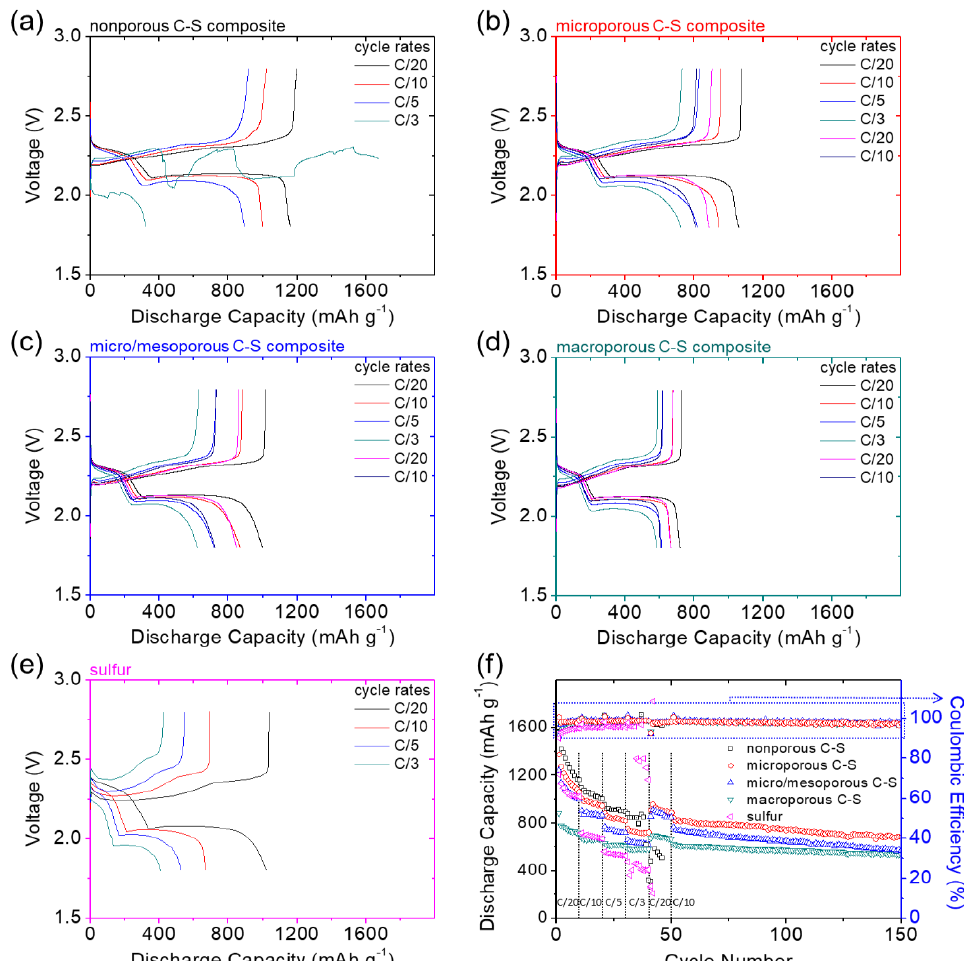
Figure 3. Rate-capability analysis of various carbon – sulfur (C – S) nanocomposites: voltage profiles of ( a ) nonporous C–S, ( b ) microporous C–S, ( c ) micro/mesoporous C–S, ( d ) macroporous C–S, and of ( a ) nonporous C – S, ( b ) microporous C – S, ( c ) micro/mesoporous C – S, ( d ) macroporous C – S, and ( e ) sulfur; ( f ) rate ( e ) sulfur; ( f ) rate capability.